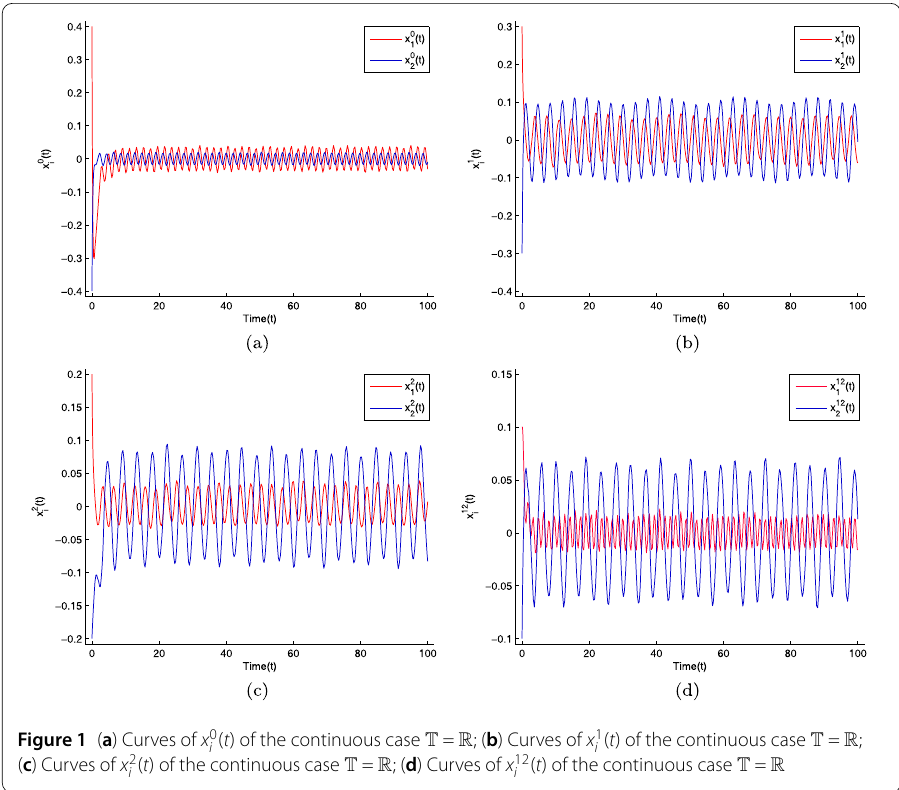
( t ) of the continuous case T = R i